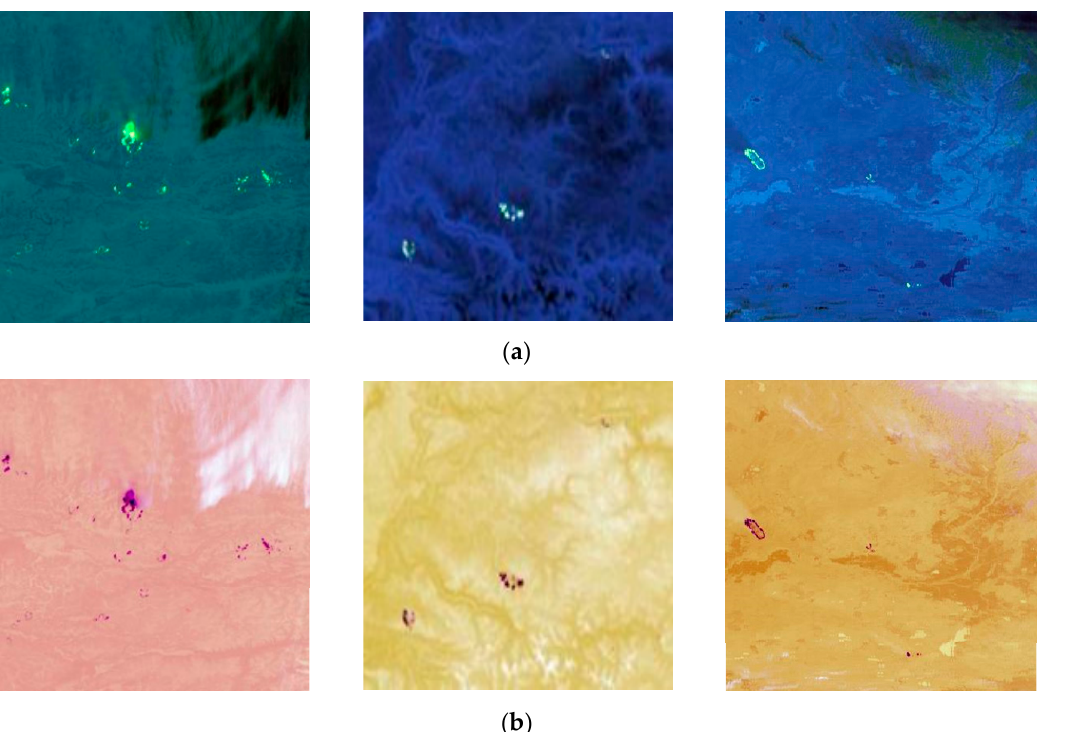
Figure 5. False ‐ color image generated from the MODIS data channel 21/22/31. In Figure 5, ( a ) is a false color image synthesized with 21/22/31 channel primary colors. The bright green area is the fire point, and the blue ‐ purple area is the background area without fire. In the same figure, ( b ) is a complementary picture synthesized by using channel 21/22/31. The purple area is the fire point and the brown area is the background area without fire.